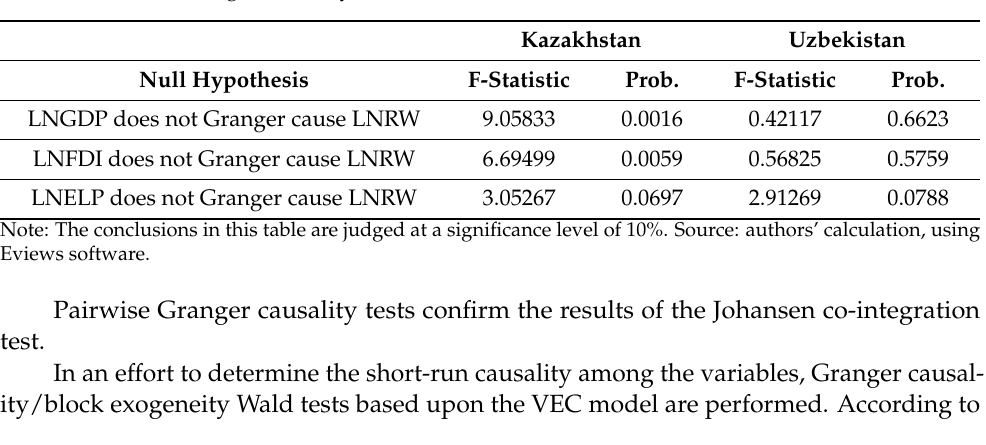
Table 9. Pairwise Granger causality